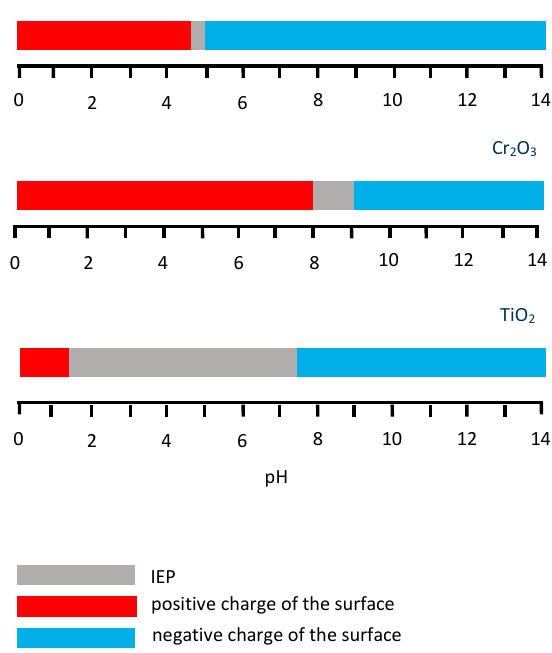
Figure 7. IEP ranges and surface charge of the BSA, Cr 2 O 3 and TiO 2 oxides.